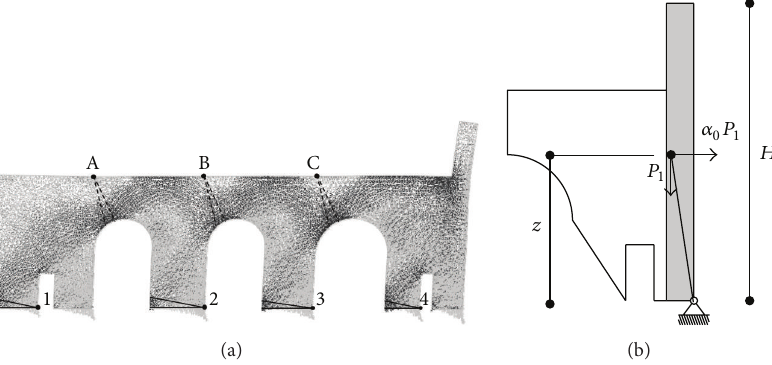
Figure 12: Nonlinear FE analysis: (a) principal stresses with the locations of crack openings for the lateral wall N2-(C1,C2,C3,S2). White and black colours correspond to compression and tension areas, respectively, and (b) illustration of the lateral section (see Figure 9(b)) used to compute the collapse load multiplier ( 𝑧 = 5.81 m and 𝐻 = 11.7 m).